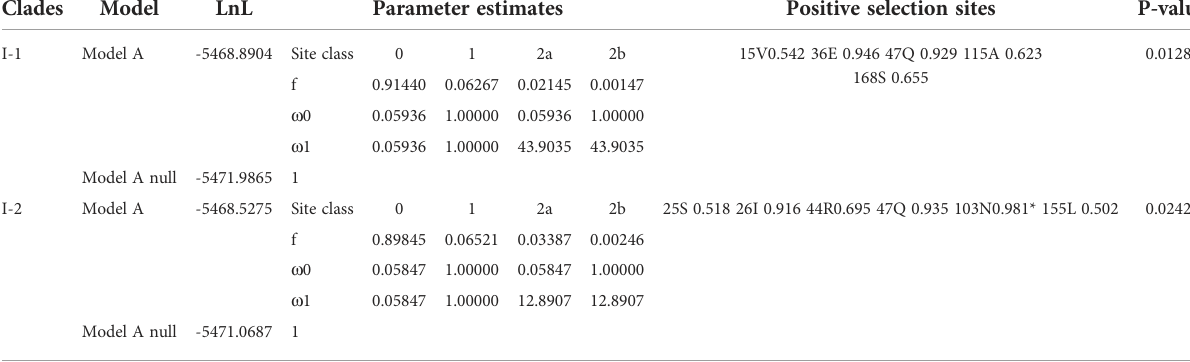
TABLE 5 Likelihood ratio test (LRT) of branch site models for the clade I. Clades Model LnL Parameter estimates Positive selection sites